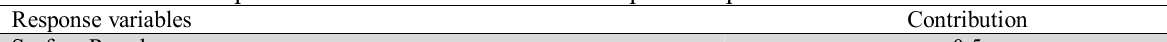
Contribution of Response Variables for the First Principal Component